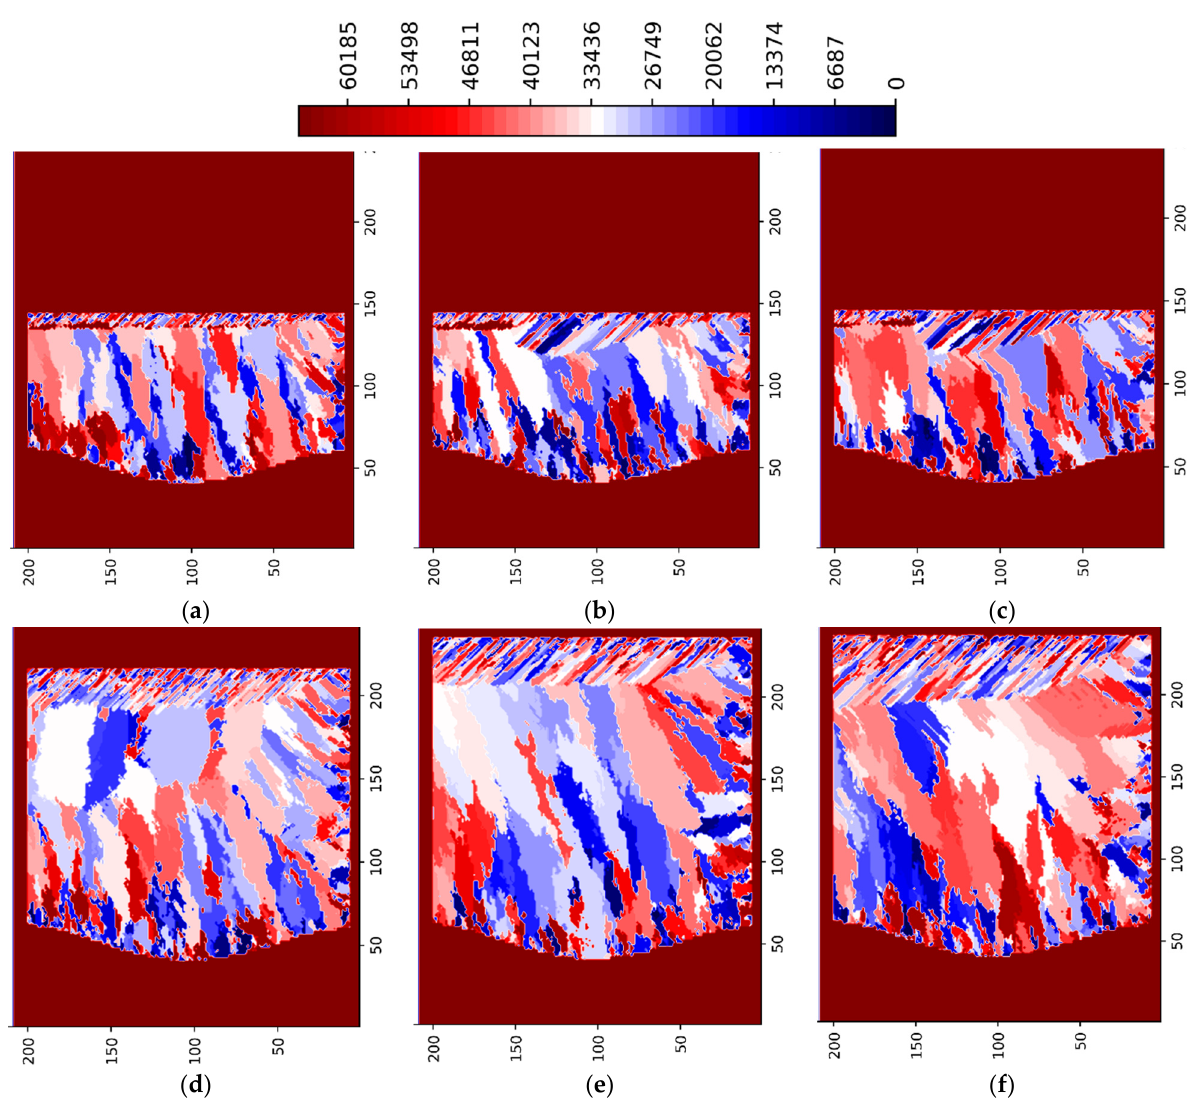
Figure 3. LPBF IN718 simulated grain structure (3 layers, 5 tracks)—ZY plane (P = 188 W): ( a ) layer 1 track 3; ( b ) layer 1 track 4; ( c ) layer 1 track 5; ( d ) layer 2 track 3; ( e ) layer 3 track 2; ( f ) layer 3 track 4.